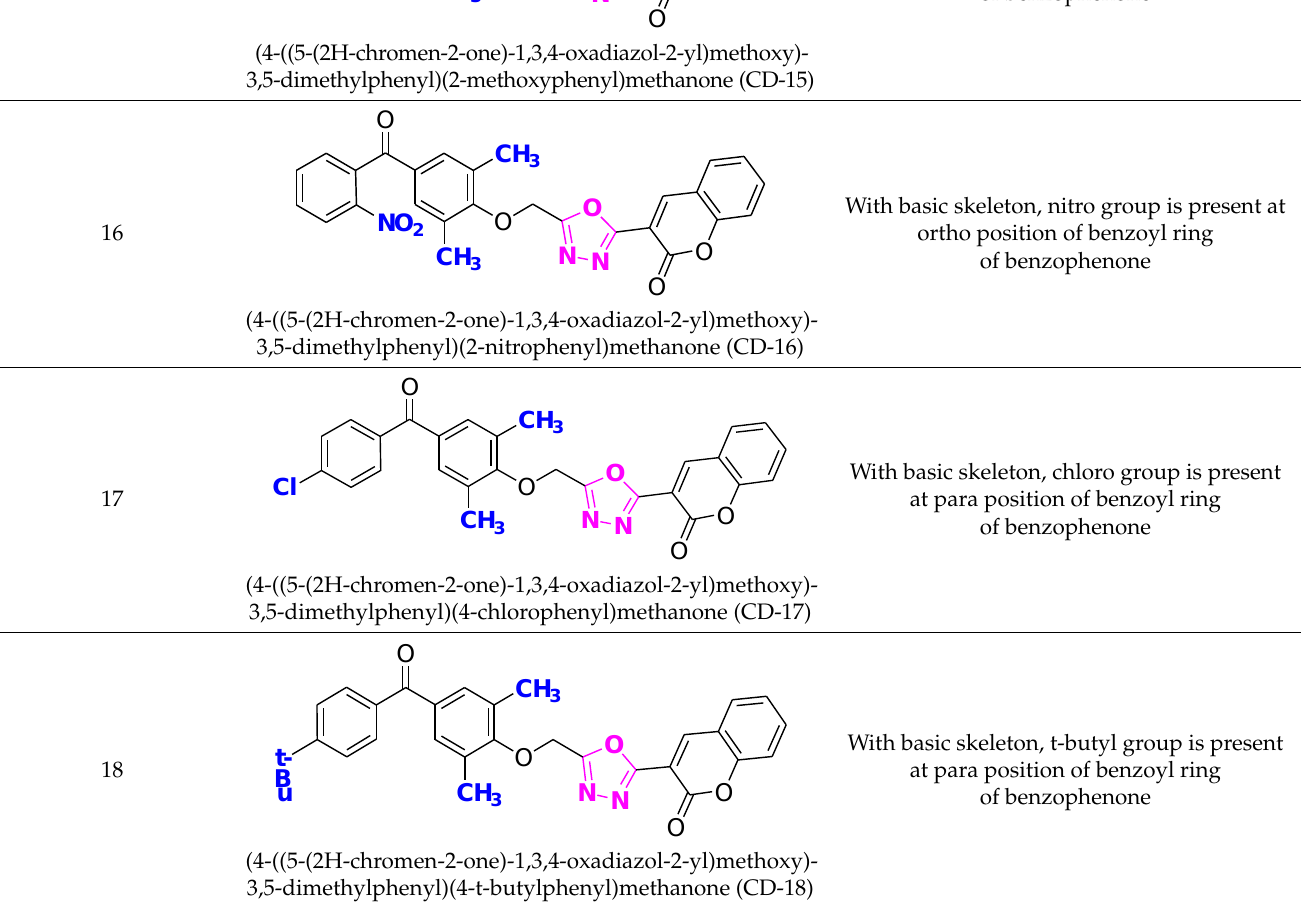
With basic skeleton, methoxy group is present at ortho position of benzoyl ring of benzophenone